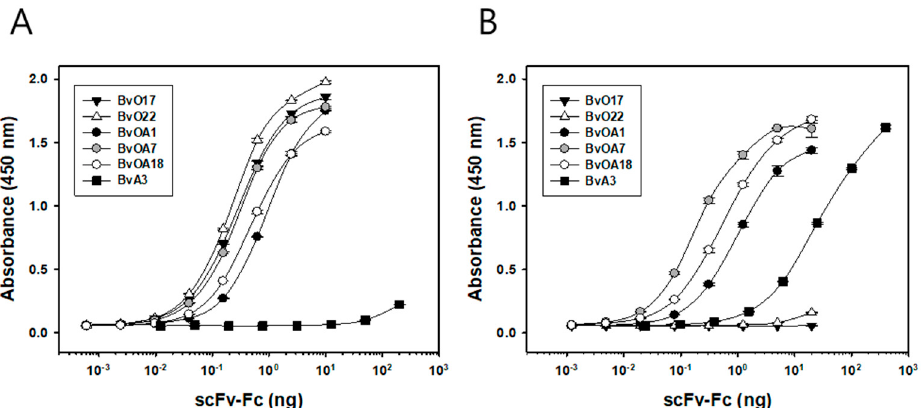
Figure 1. Binding activities of selected bovine scFvs toward ( A ) FMDV type O (O1 Manisa) and ( B ) FMDV type A (A22 Iraq) antigens. scFv sequences selected by phage library screening of FMDV-immunized cattle were cloned into a pDR-OriP-Fc1 vector, which allowed scFv-Fc expression in mammalian cells. Serial dilutions of purified scFv-Fc were applied onto FMDV antigen-coated 96-well Maxisorp plate. Bound scFv-Fc proteins were detected using HRP-conjugated anti-human IgG (Fc-specific). Data are shown as mean ± SD of triplicate samples.